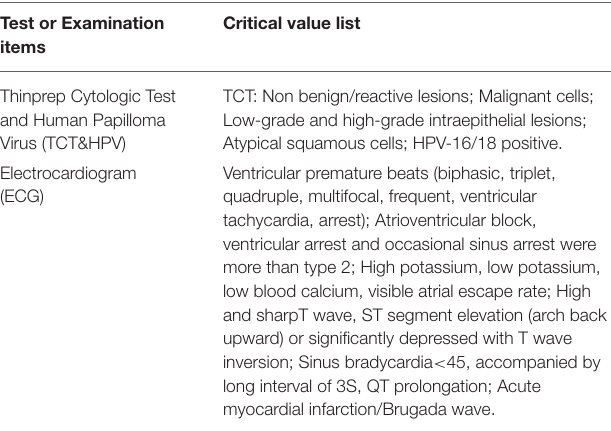
TABLE 3 | The critical value list in health checkup for cervical cancer screening and electrocardiogram. Test or Examination items